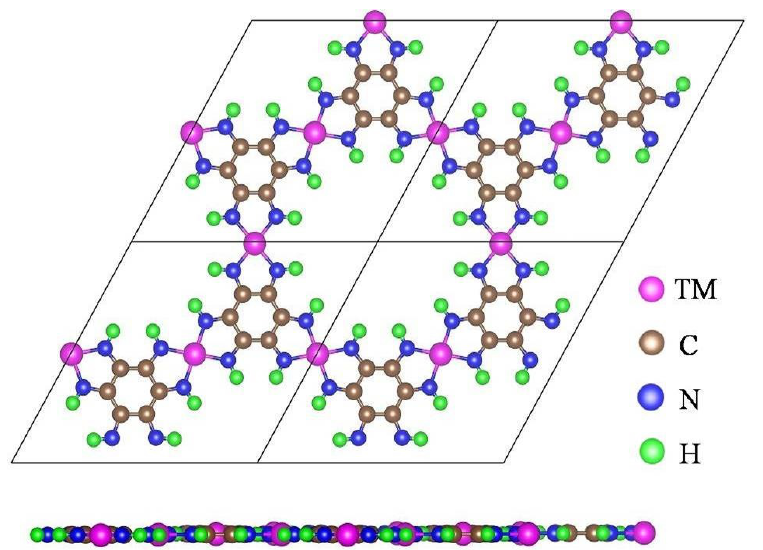
Figure 1. The top ( up ) and side ( down ) views of the structures in a 2 × 2 supercell for ten TM-HAB monolayers. Table 1. Hirshfeld charge on metal atoms (Q TM ) and on nitrogen atoms (Q N ) for the ten